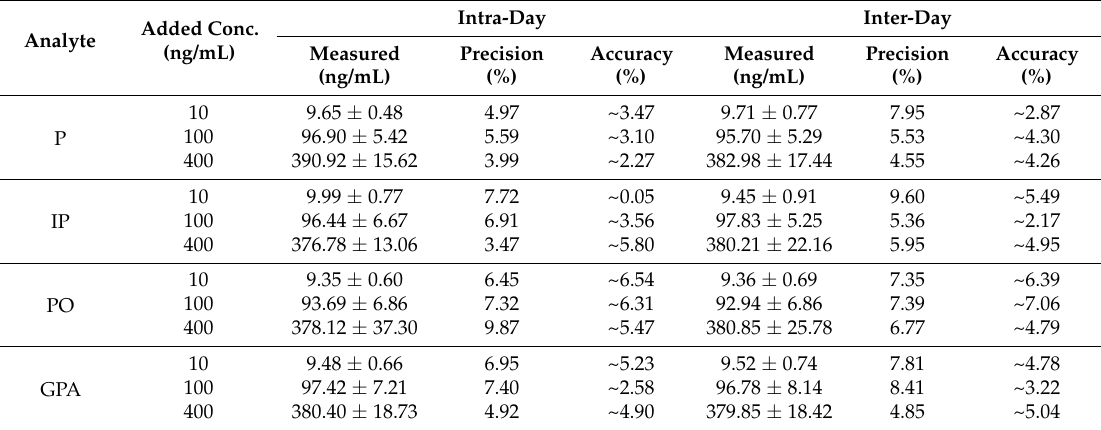
Table 1. Precision and accuracy of four analytes in cell lysate.